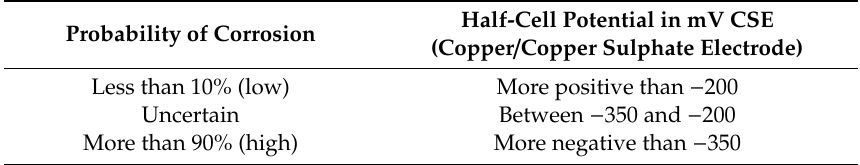
Table 2. Electrochemical potential in relation to corrosion probability based on ASTM C876